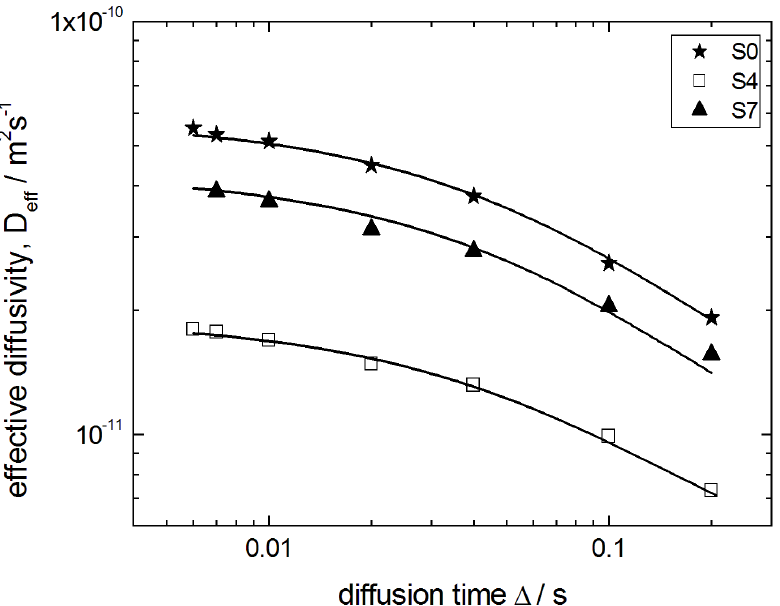
D of n-heptane in the initial silica gel S0 and the Figure 10. Effective diffusivities eff transformation products S4 and S7 as a function of the observation time  . Solid lines show best fits of Equation (1) to the